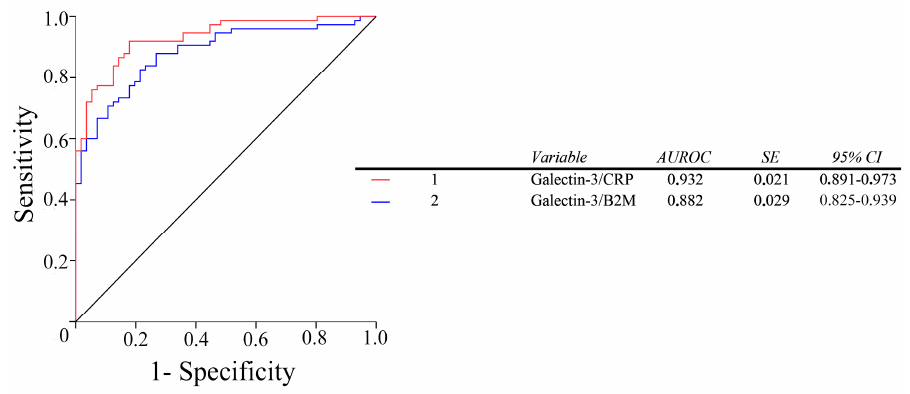
Figure 6. Receiver operating characteristics (ROC) plots for the galectin-3/CRP and galectin-3/B2M ratios in PAD patients and in the control group. AUROC: areas under the curve of the ROC plots. SE: Standard Error.